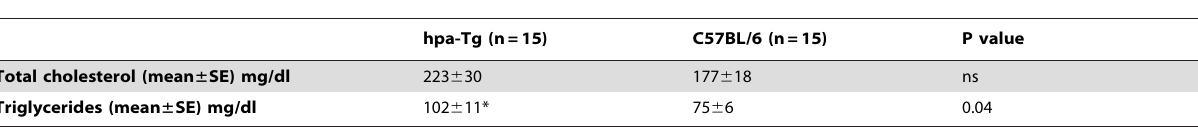
Table 1. Serum lipid profile of hpa-Tg and control C57BL/6 mice.